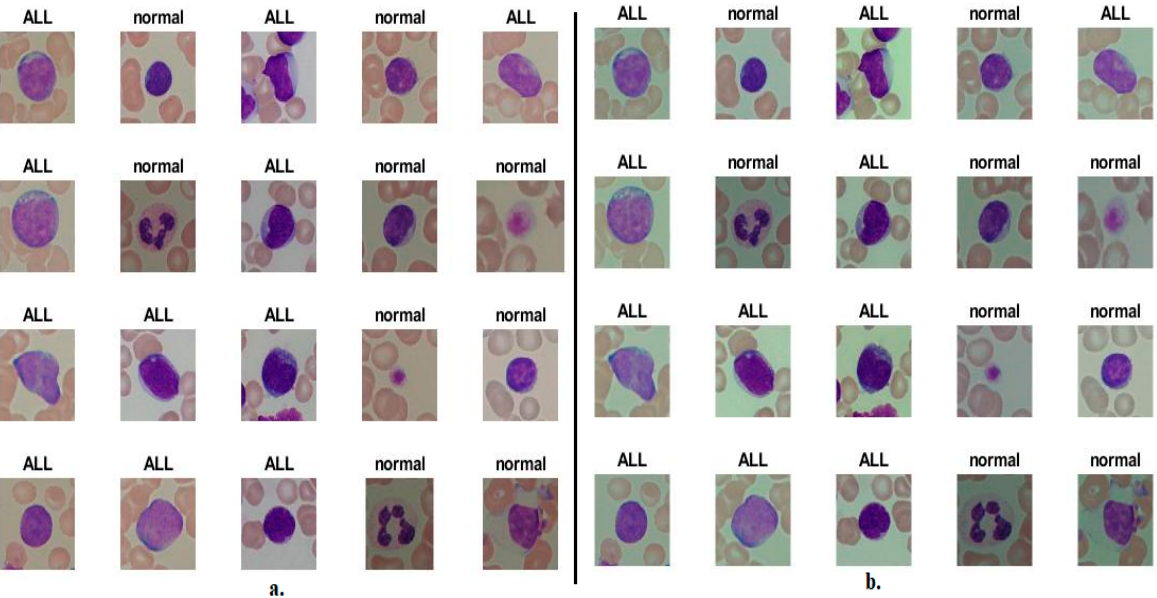
Figure 3. A random selection of images from the ALL_IDB2 dataset ( a ). Before improvement. ( b ) After improvement.